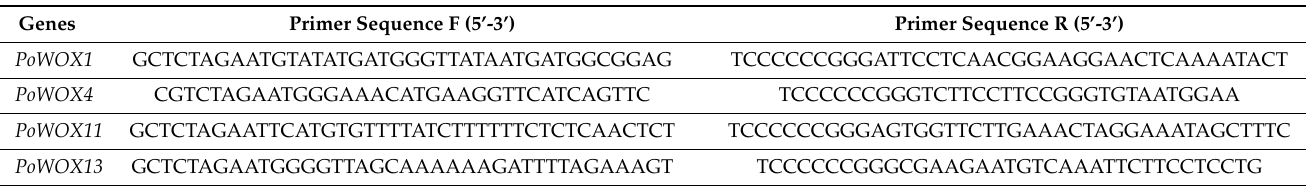
Table 1. Primer sequences of PCR